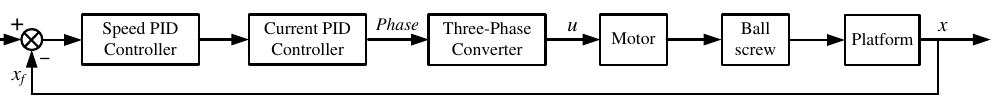
Figure 8. PID controller model for